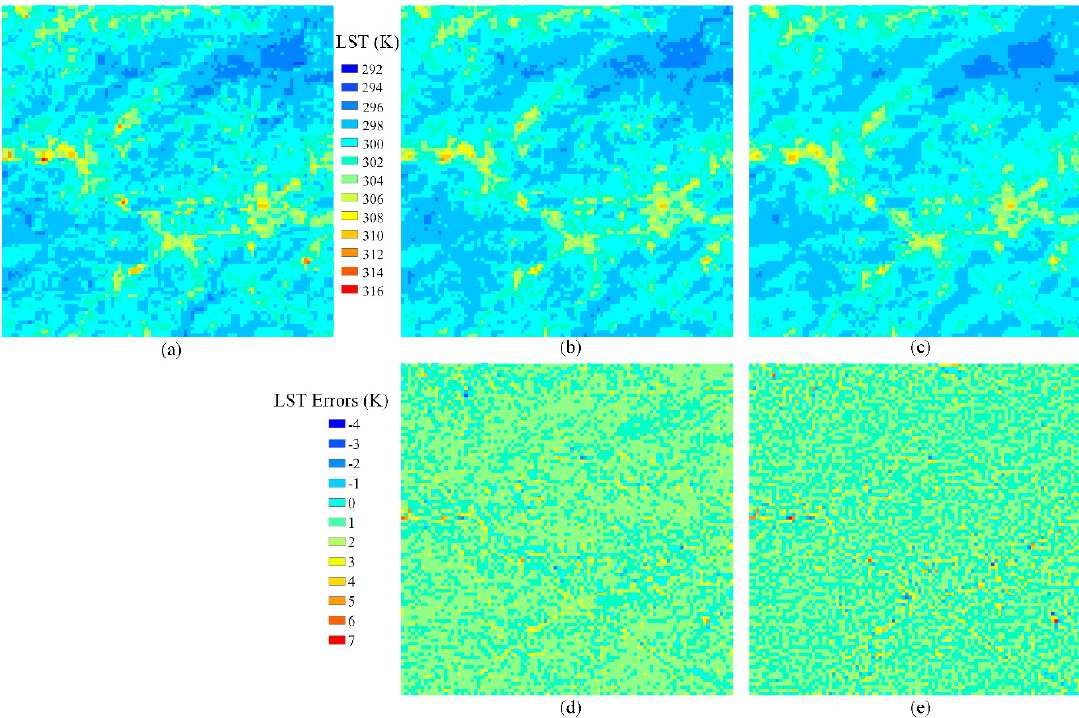
Figure 7 . Spatial distribution of LSTs in region B. ( a ) 90 m ASTER LST; ( b ) 90 m downscaled RFATPK LST; and ( c ) 90 m downscaled TsHARP